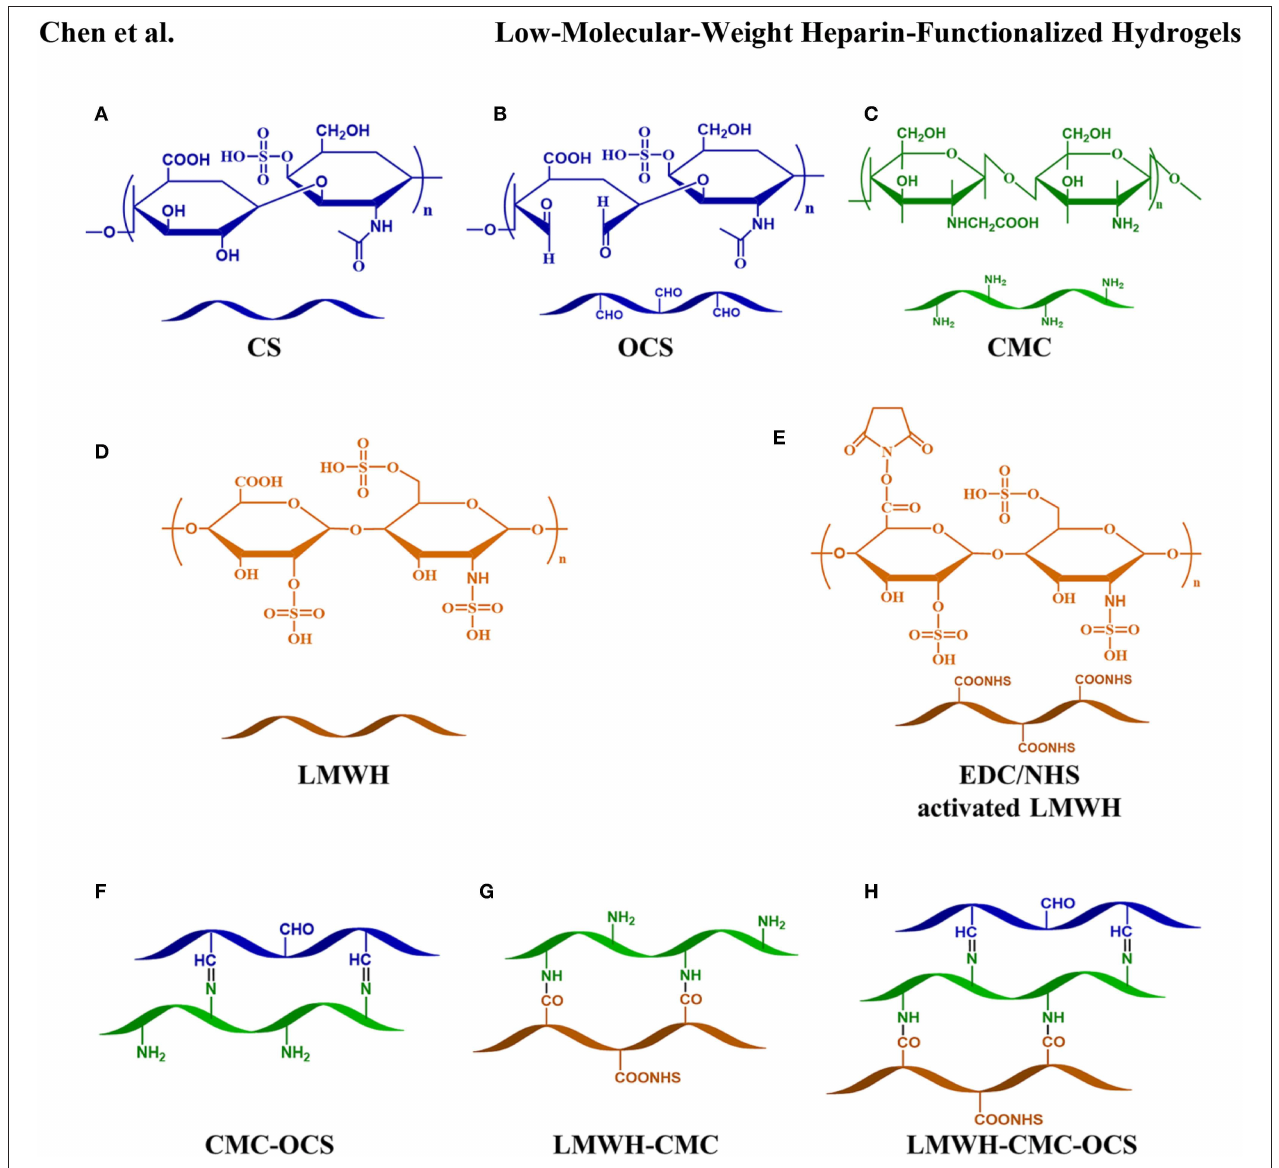
FIGURE 2 | Chemical structures of CS (A) , OCS (B) , CMC (C) , LMWH (D) , EDC/NHS activated LMWH (E) and schematic diagram of various cross-linked reaction in hydrogels (F–H) .